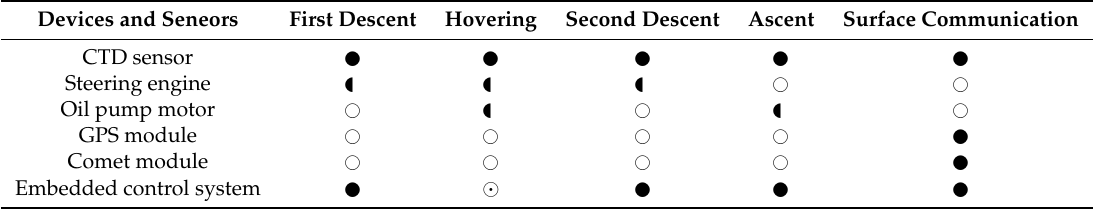
Table 1. The running states of devices and sensors of the deep-sea self-sustaining profile buoy (DSPB) in the whole working